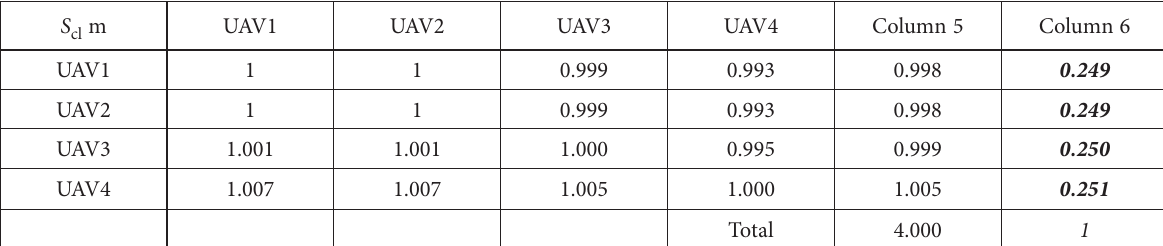
Table 10. Matrix of static ceiling